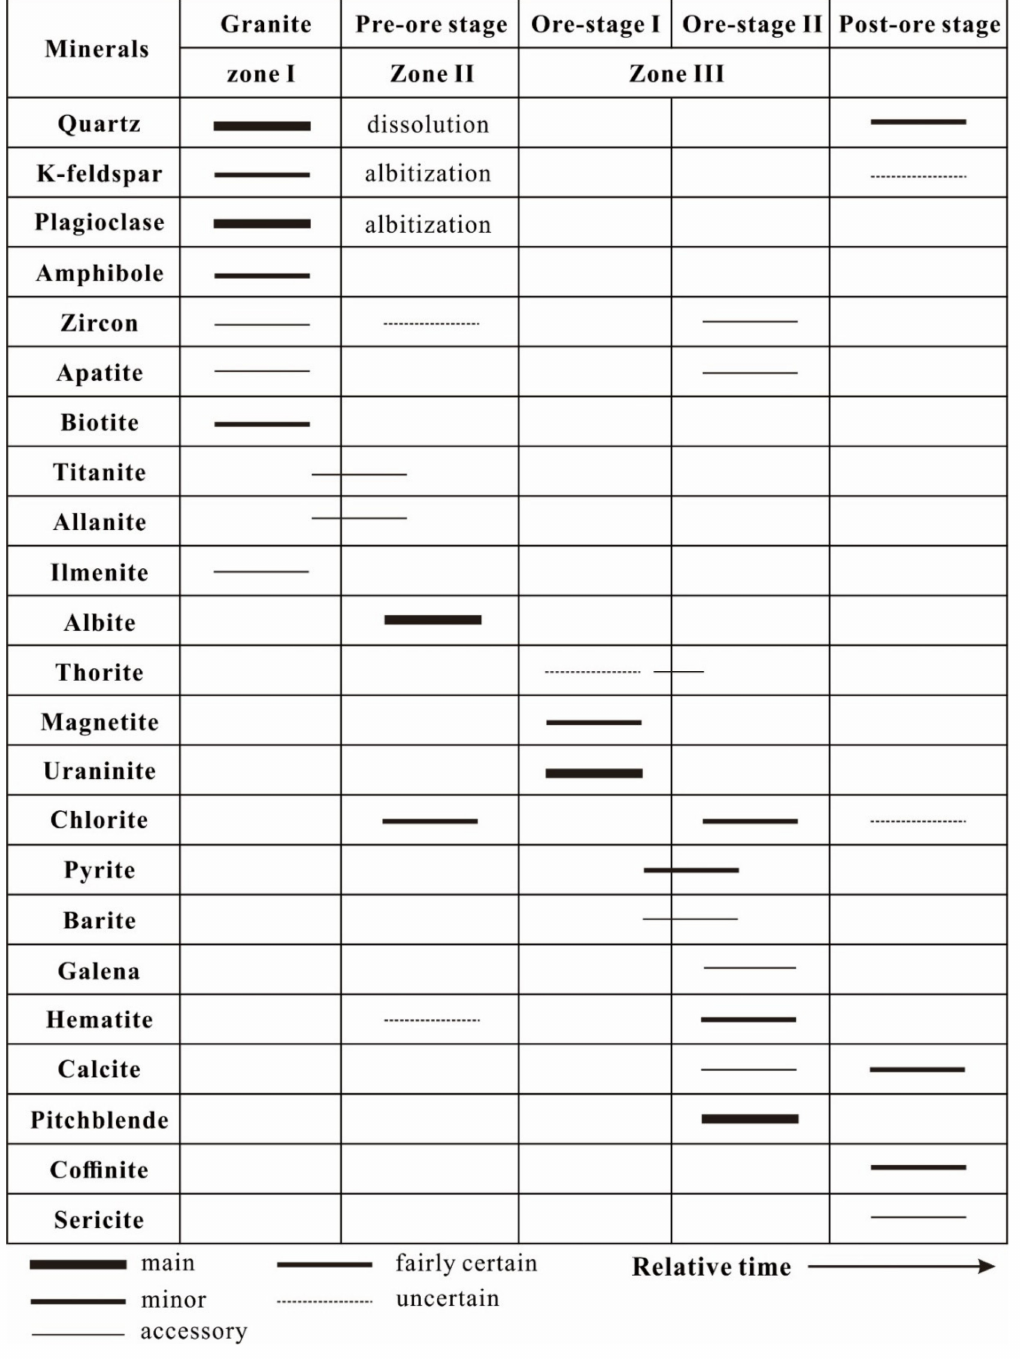
Figure 3. Mineral paragenesis of the Jiling Na metasomatism uranium